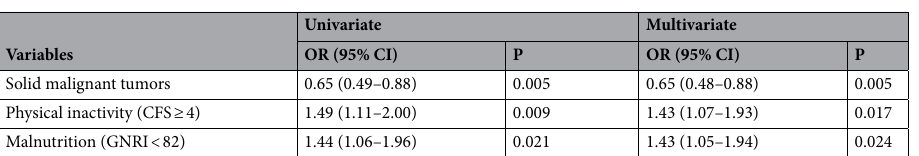
Table 4. Cox regression for fail to home discharge. OR odds ratio, CI confidence interval, CFS Clinical Frailty Scale, GNRI Geriatric Nutritional Risk